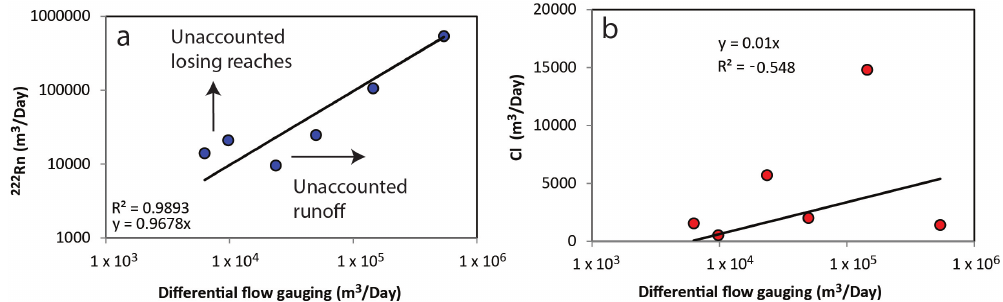
Fig. 12. Groundwater discharge to the Tambo River by differential flow gauging ( x axis) versus groundwater discharge given by 222 Rn mass balance (a) and Cl mass balance (b)